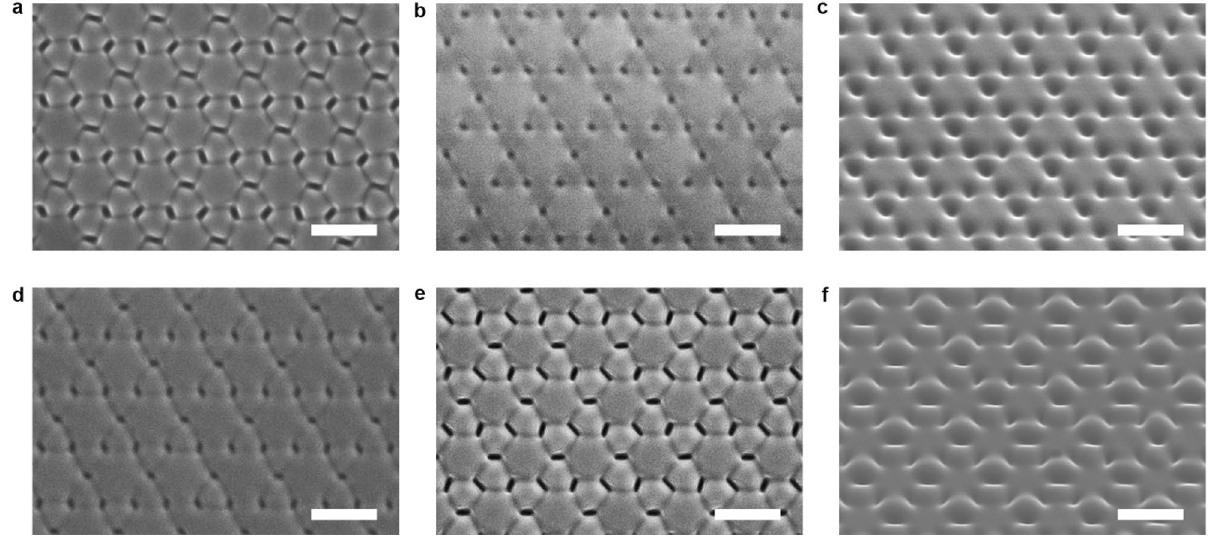
Figure 5. Typical SEM images of the IA-Chol submicron pillar arrays after irradiation with the right-hand circularly polarized light for different time periods. ( a ) Top-view SEM image of the array after being irradiated for 9 min. ( b ) Top-view SEM image of the array after being irradiated for 10 min. ( c ) Side-view SEM image corresponding to panel ( b ). ( d ) Top-view SEM image of the array after being irradiated for 11 min. ( e ) Top-view SEM image of the array after being irradiated for 12 min. ( f ) Side-view SEM image corresponding to panel ( e ). The light intensity was 300 mW cm −2 . The scale bars of all the SEM images correspond to 1 μm.